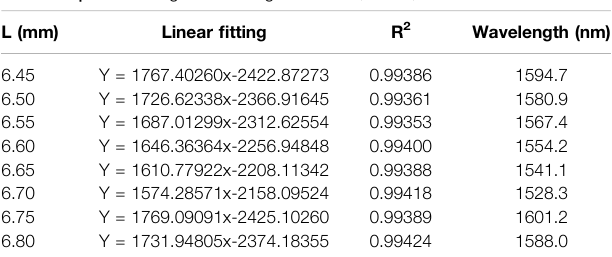
TABLE 3 | Linear fi tting of wavelength shift at 1,500 – 1,650